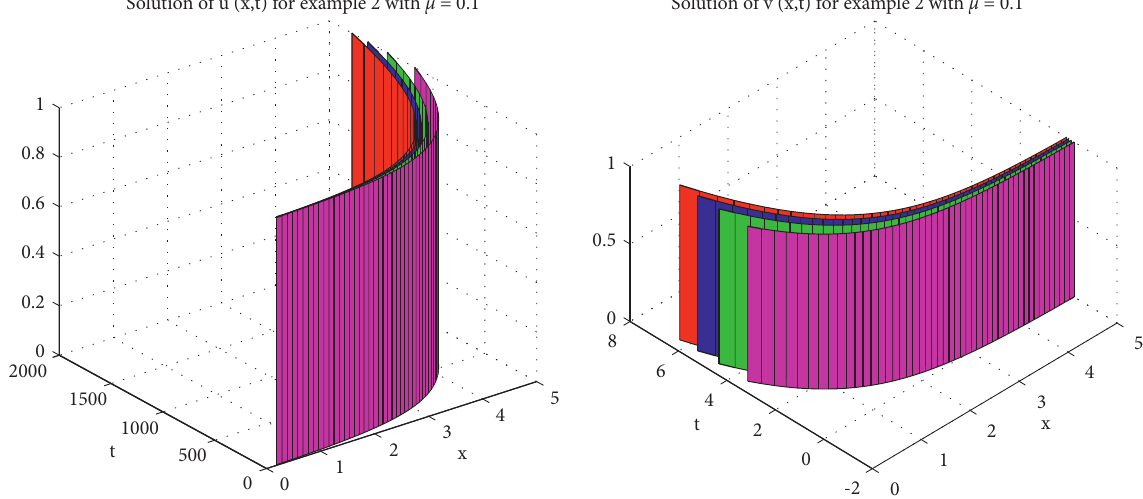
Figure 4: 3D graphical representation for u ( t, x ) and v ( t, x ) of equation (30).